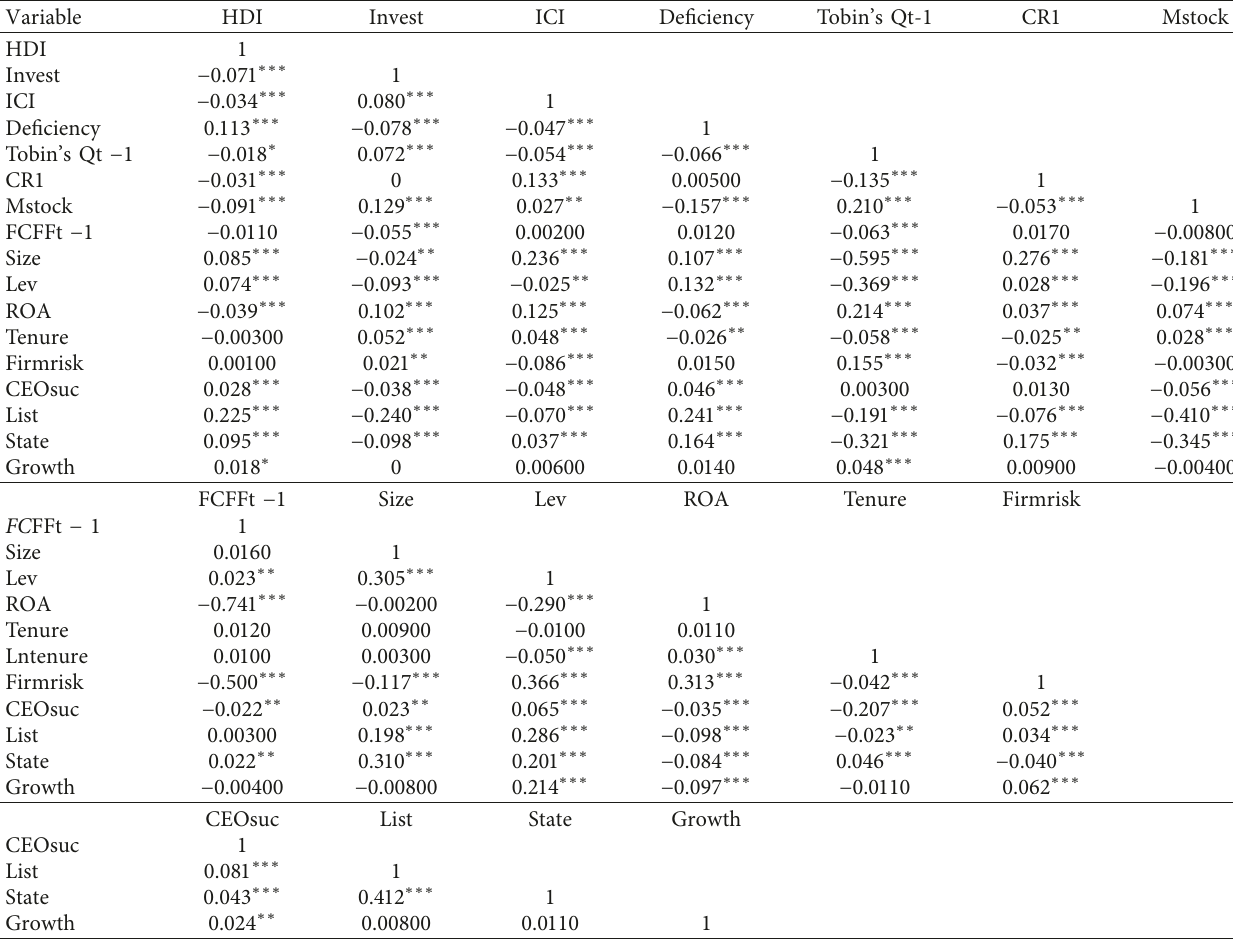
Table 3: Pearson’s correlation coefficient analysis of main